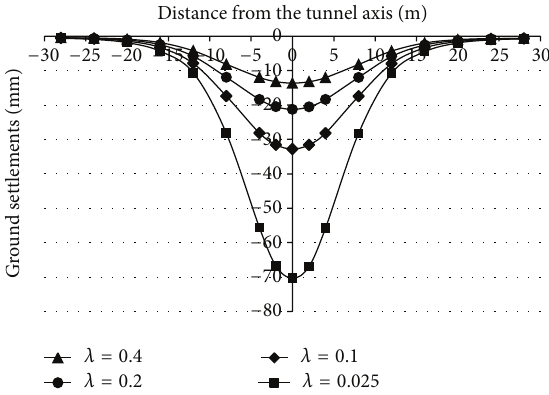
Figure 13: Relation curves between the supporting pressure and the horizontal ground settlements in the silt strata. Table 3: Critical supporting pressure of the DOT shield tunnel. Strata Theoretical results (kPa) Numerical results (kPa) Sand 23 20 Silt 10.7